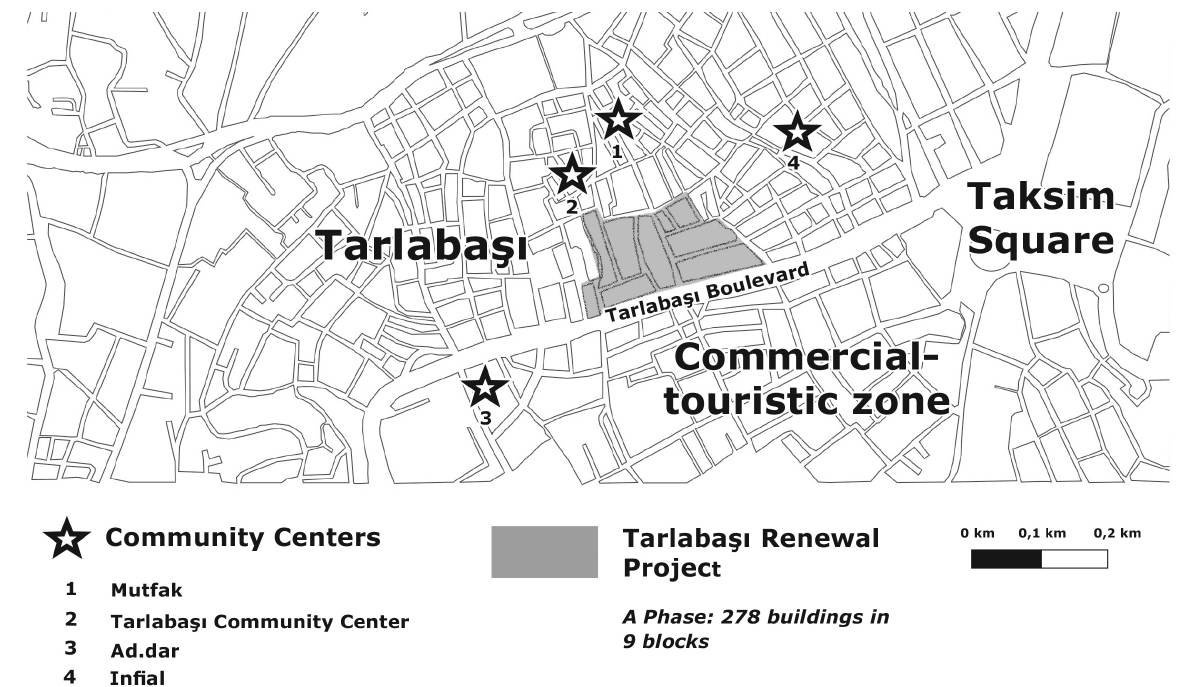
Figure 3. Positions of community centers and the Tarlabaşı renewal project. Source: Author. ning since 2012, aims to build “a social center formed by migrants themselves, as well as a space of interaction where different struggles would interact and have a prop- agative quality” (Genç, 2017, p.